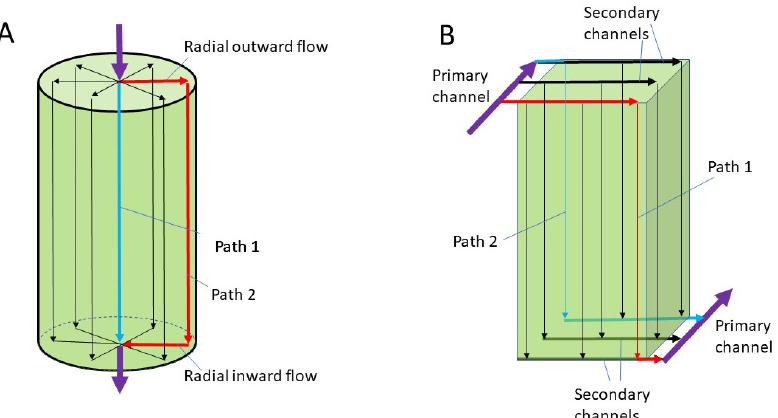
Figure 2. ( A ) Idealized flow paths in a conventional cylindrical packed bed. ( B ) Idealized flow paths in a z 2 cuboid packed bed.